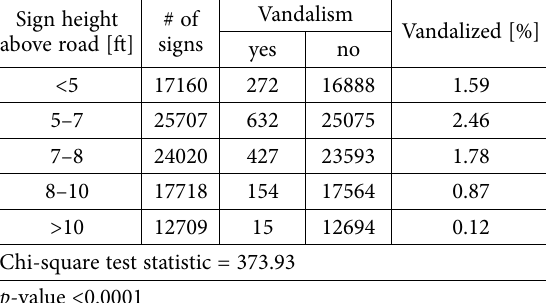
Table 5. Traffic sign vandalism by mount height